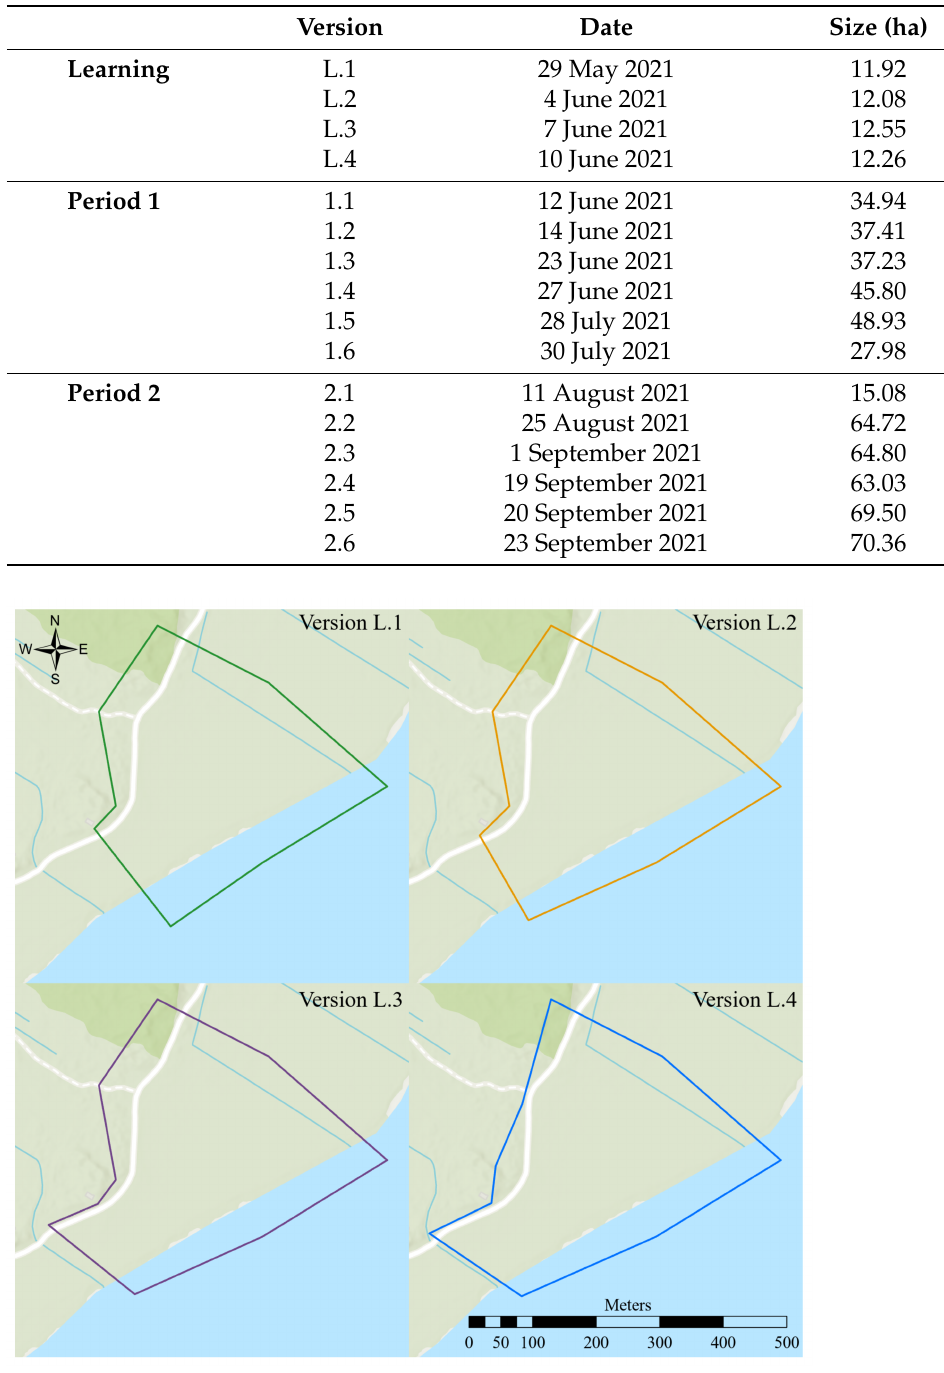
Figure A2. The virtual enclosure during the learning period . The coordinates of the lower right corner of each map frame are 8 ◦ 27 (cid:48) 59 (cid:48)(cid:48) E 55 ◦ 24 (cid:48) 4 (cid:48)(cid:48)